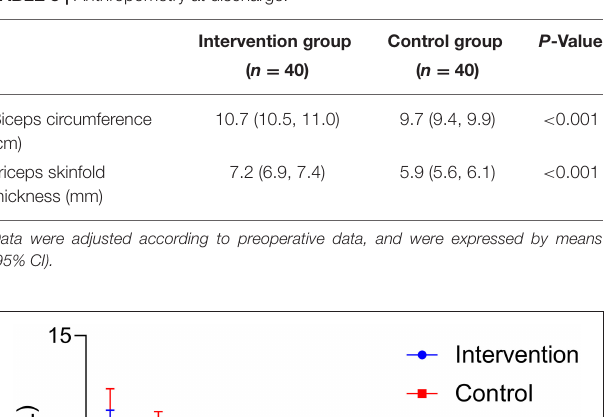
FIGURE 2 | Postoperative blood glucose fluctuations between the two groups. LAGE, largest amplitude of glycemic